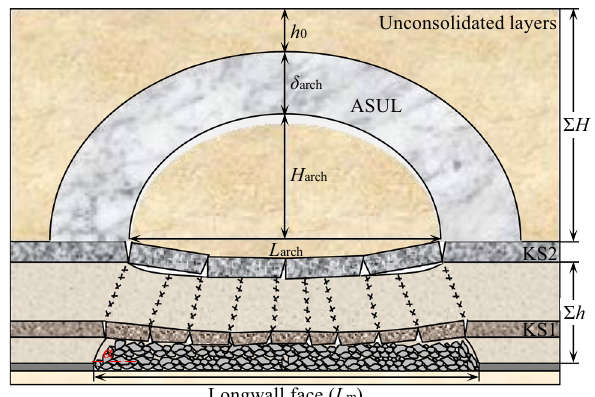
Figure 2. Diagram of the ASUL 22